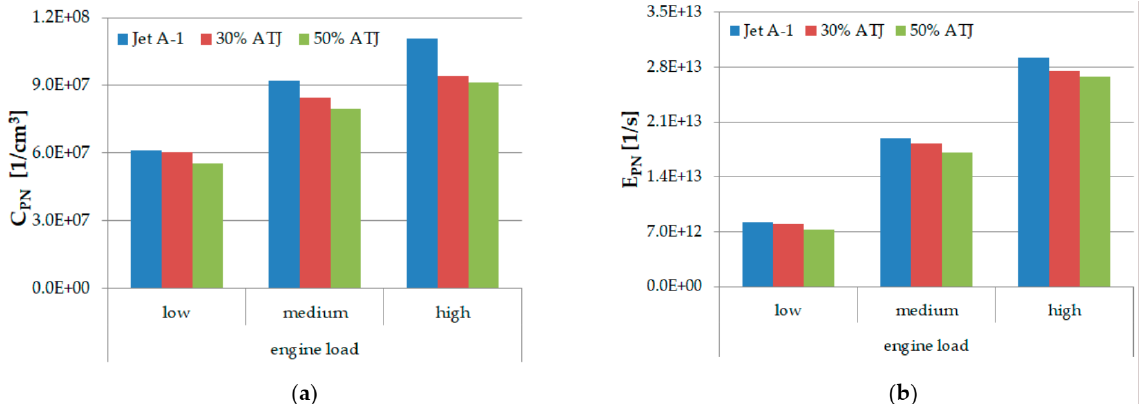
Figure 8. The number concentration C PN ( a ) and intensity of the particles number emission E PN ( b ) for tested fuels in three ranges of engine operation.